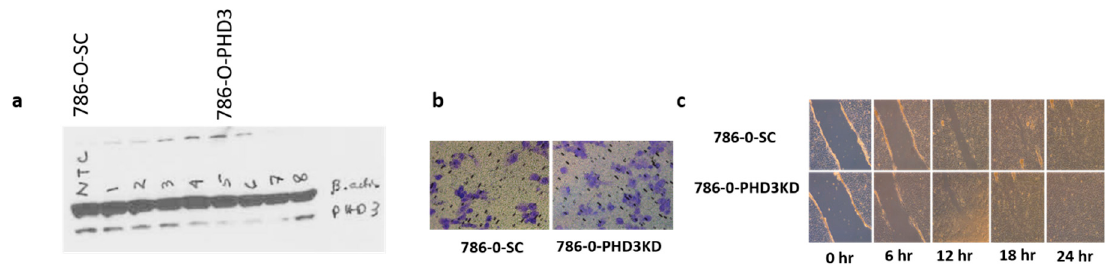
Figure A1. 786-O cell line in vitro assays: Using viral transfection PHD3 was knocked down. ( a ) Western analysis illustrating the level of PHD3 expression in 786-O-SC versus PHD3 knockdown clones. Clone 5 used in all further experiments (labeled as 786-O-PHD3KD). ( b ) Migration assays revealed that more 786-O-PHD3KD cells than 786-O-SC cells migrated in 12 h (3 wells per cell type stained). ( c ) Wound healing assays revealed that 786-O-PHD3KD cells (bottom row) showed faster wound healing within 18 h compared to 786-O-SC cells (top row).